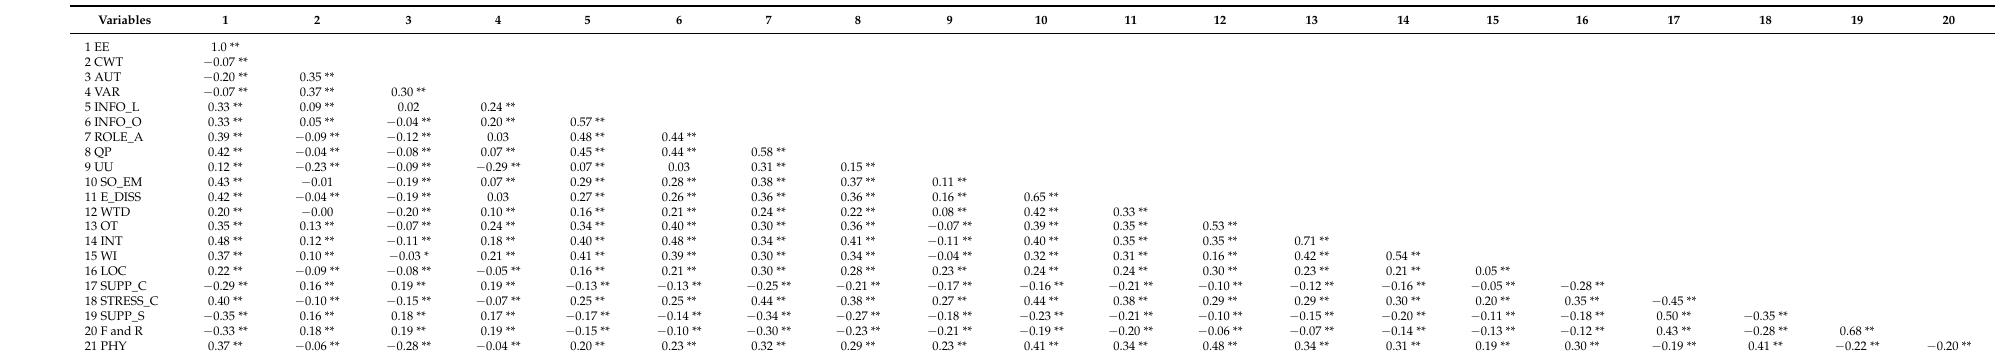
Table 2. Intercorrelations for all study